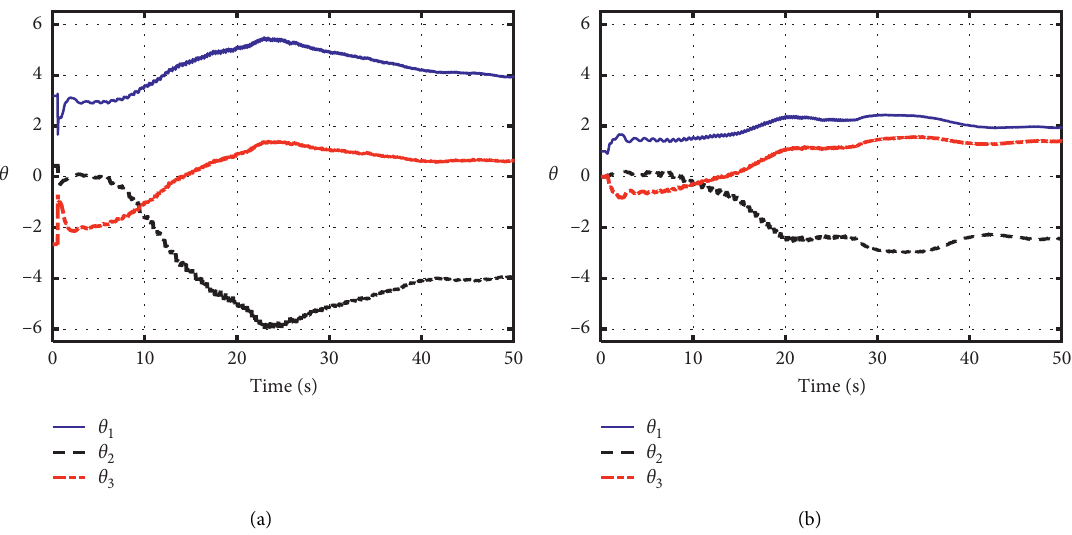
Figure 8: Time histories of estimated parameters with swept loading target. (a) The SADC method. (b) The TADC method. Table 1: Evaluation indexes of 10Hz swept signal loading. Compensation